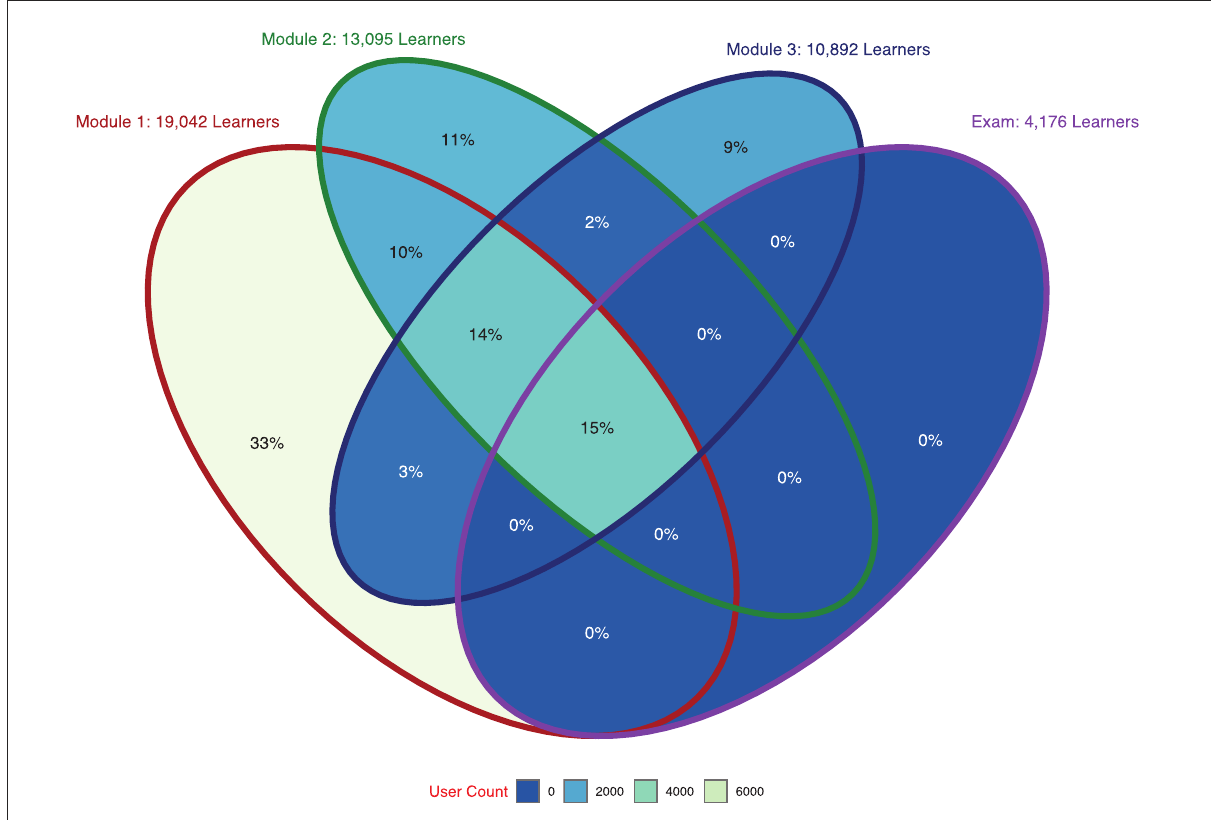
FIGURE3 Active participation in the module series (i.e., ISec 2019 , ISec 2021 , ISec 2022 , and WWW 2021 ). The Venn diagram visualizes how many users participated in any given combination of course modules or the final exam